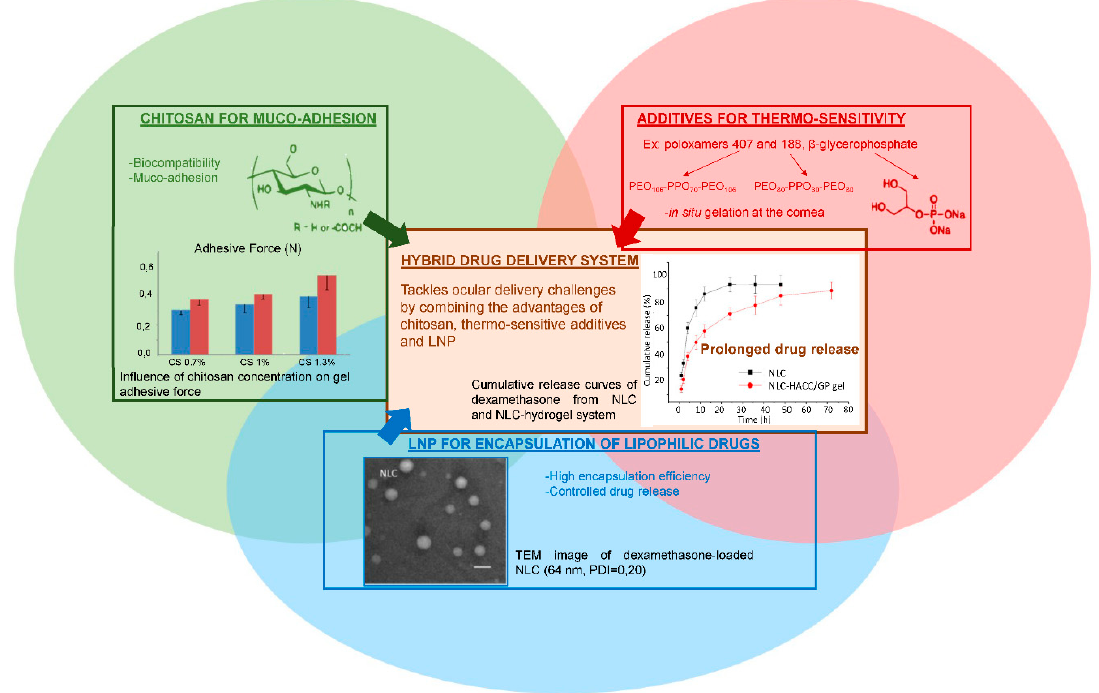
Figure 8. Advantages of combining several components to formulate an innovative drug delivery system that meets ocular administration route expectations. Adapted from [14,34,54].